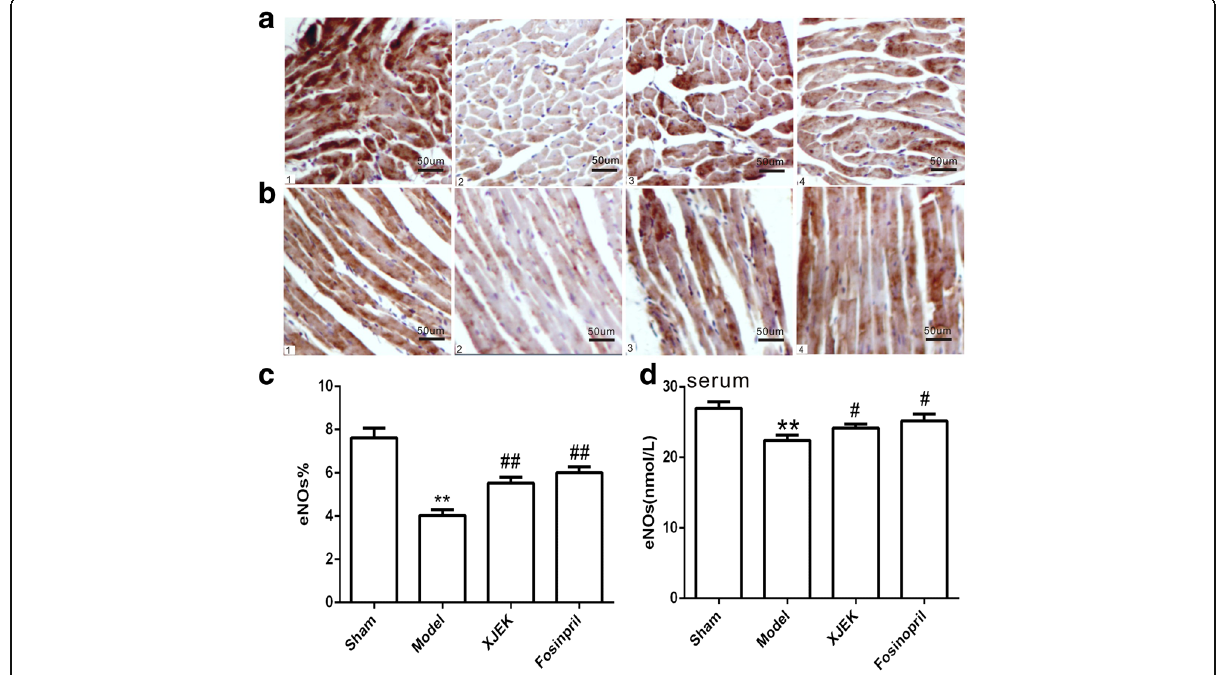
Fig. 8 Effect of XJEK on eNOS content in serum and cardiac tissues of MI mice. a Representative images of cardiomyocyte cross-section with immunohistochemistry (magnification × 400); b Representative images of cardiomyocyte long axis with immunohistochemistry (magnification × 400); c Quantitative analyses results (mean ± SEM, n = 6 – 9). d eNOS content in serum (mean ± SEM, n = 6 – 9) (1) Sham group; (2) Model group; (3) XJEK group; (4) Fosinopril group. * P < 0.05, ** P < 0.01 vs. Sham group; # P < 0.05, ## P < 0.01vs.Model